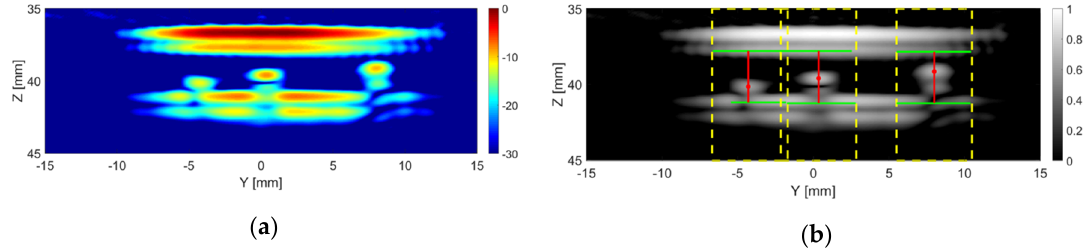
Figure 12. An example current frame from the CECAT with the particles detected: ( a ) is the TFM image and ( b ) presents the particle detection algorithm image result. The dashed yellow lines indicate the regions in which a particle was detected. The solid red lines represent the distance from the particles (red dots) to the top and bottom inner walls of the tube (solid green lines).